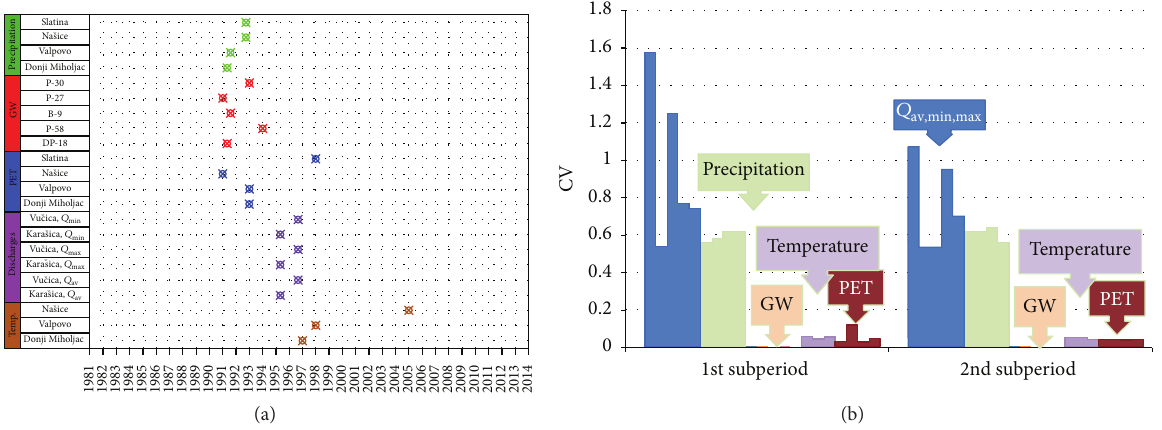
Figure 9: (a) Duration of subperiods distinguished by RAPS and (b) coefficients of variation (CV) of analysed parameters.